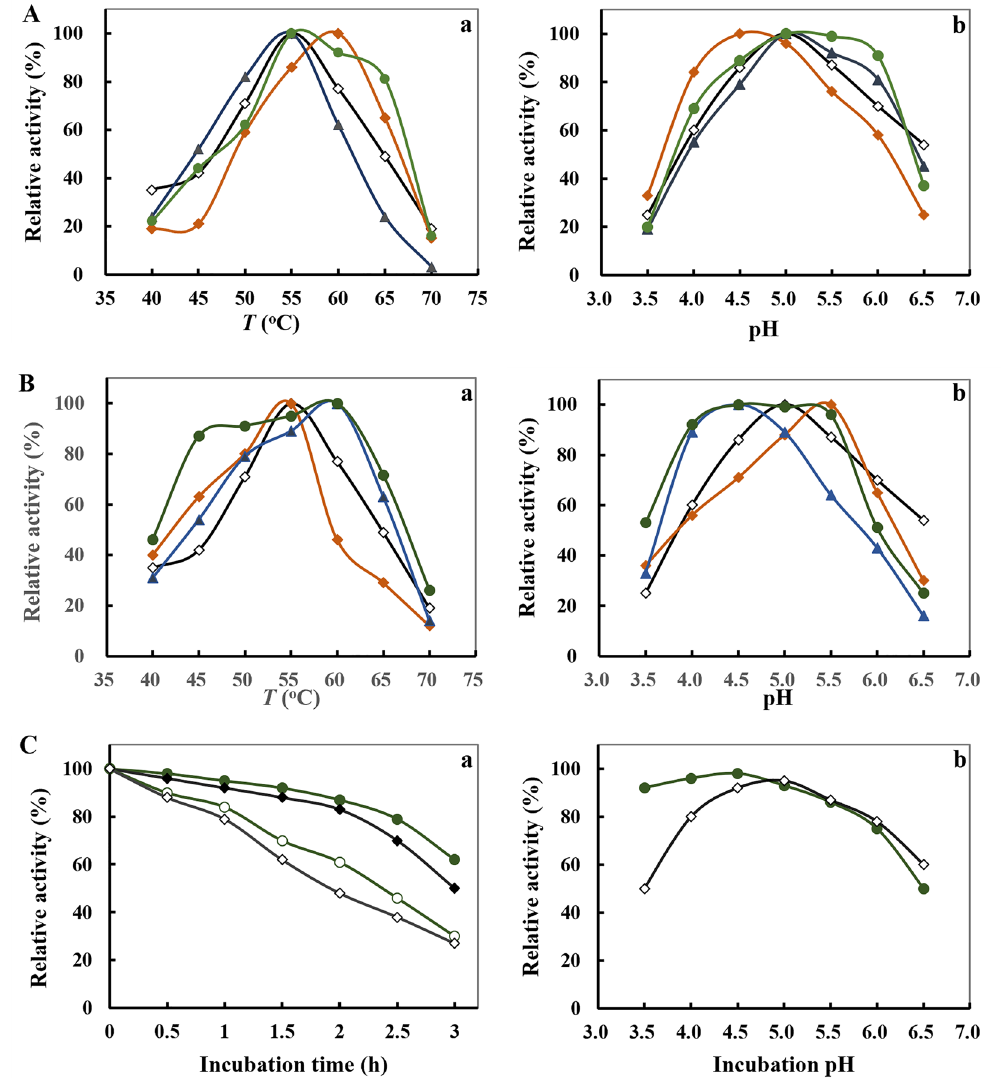
Figure 3. Effects of temperature ( a ) and pH ( b ) on the enzymatic activity of PulA mutants. ( A ) The temperature and pH optima of PulA (open diamond) and its single-site mutants N467G (solid diamond), N492A (solid triangle) and N709R (solid circular). ( B ) The temperature and pH optima of the multiple-site mutants PulA2-1 (N467G-N492A) (solid rectangle), PulA2-2 (N467G-709R) (solid triangle), PulA-N3 (N467G- N492A-N709R) (solid circular) and PulA (open diamond). ( C ) Thermostability and pH stability of PulA-N3 (circle) compared with PulA (diamond). The enzymes were incubated at 50 °C (solid icon) or 60 °C (open icon) for up to 3 h, or at different pH for 1 h. The residual activities were determined according to the Materials and Method section. The data were represented as average of triplicate